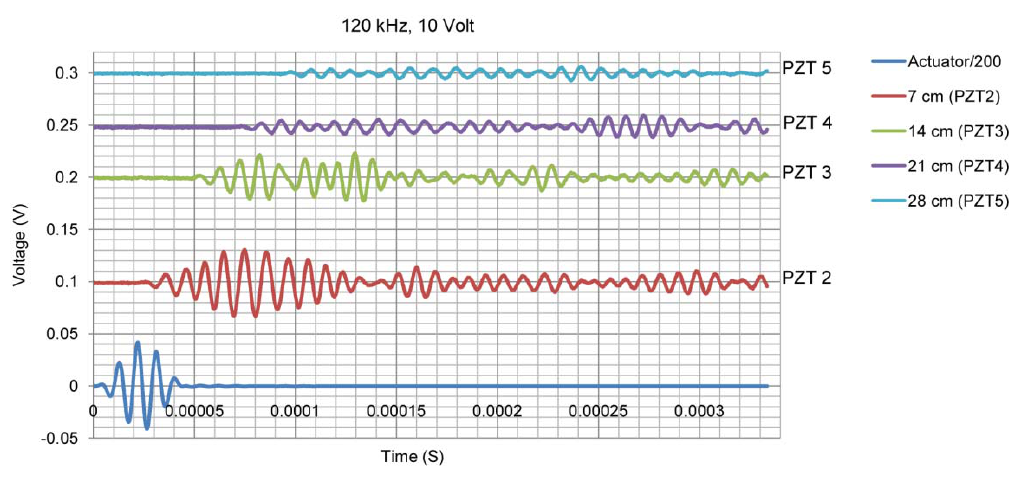
Figure 6. Wave propagation at frequency of 120 kHz with PZT 1 as